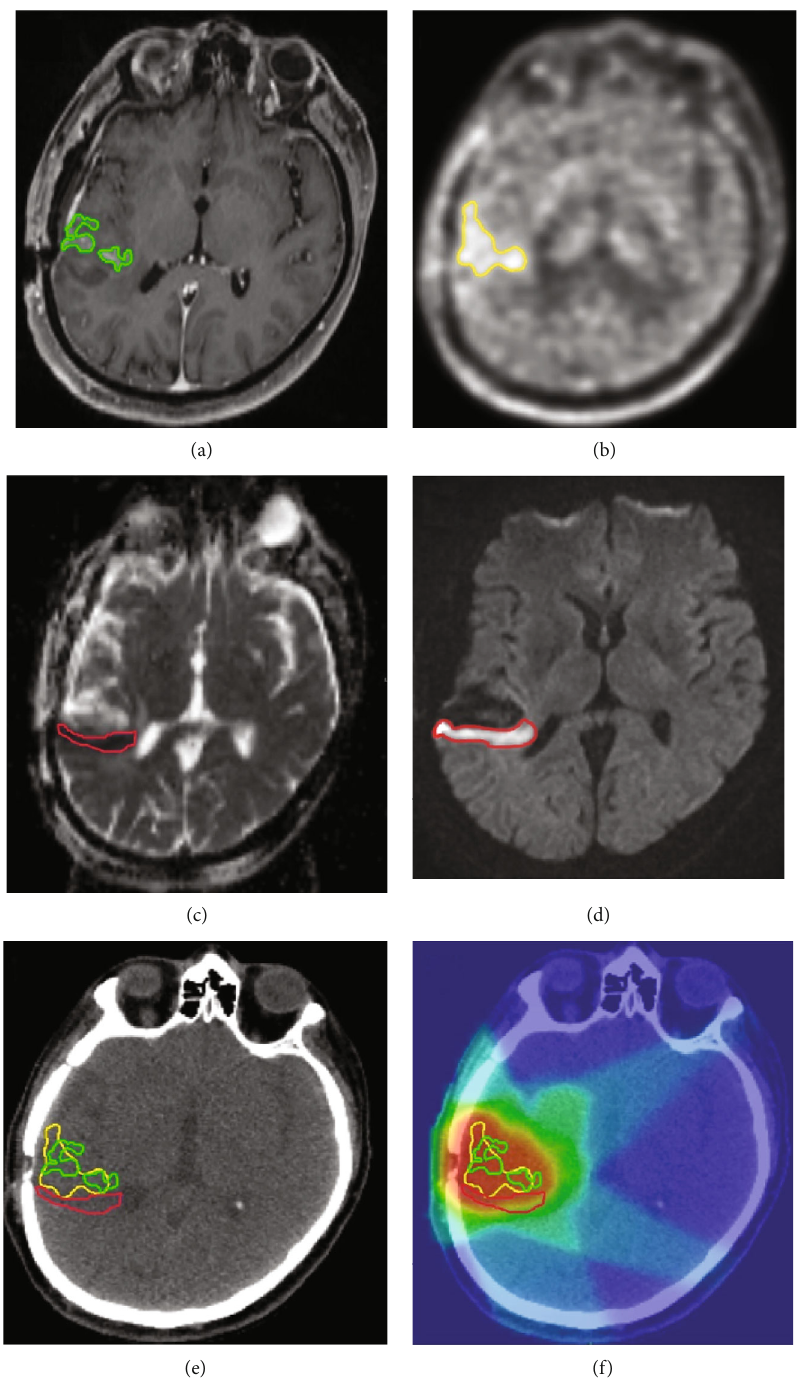
Figure 2: FET PET combined with DWI in recurrent glioblastoma (histologically con fi rmed). (a) Axial postcontrast T1-weighted MRI, green: gross total volume (GTV). (b) Axial FET PET, yellow: GTV on PET. (c) ADC map, red: GTV by ADC (low), corresponding to a hyperintensity in (d) DWI-MRI. (e) Illustration of all three volumes on planning CT. (f) Dose distribution of the treatment plan based on FET PET. The volumetric comparison thus revealed that the majority of the GTVs-ADC (low) is located outside areas of contrast enhancement in postcontrast T1-weighted MRI (mean nonoverlapping volume 66 : 2 ± 24 : 6 % , median 72.2%, and range 5.8 – 100%) and also outside areas of increased FET uptake (mean nonoverlapping volume 76 : 4 ± 64 % , median 69 : 5 % , and range 12.3 – 385.1% in the total cohort, n = 41 ). Reproduced with permission from Figure 3 in Popp et al.